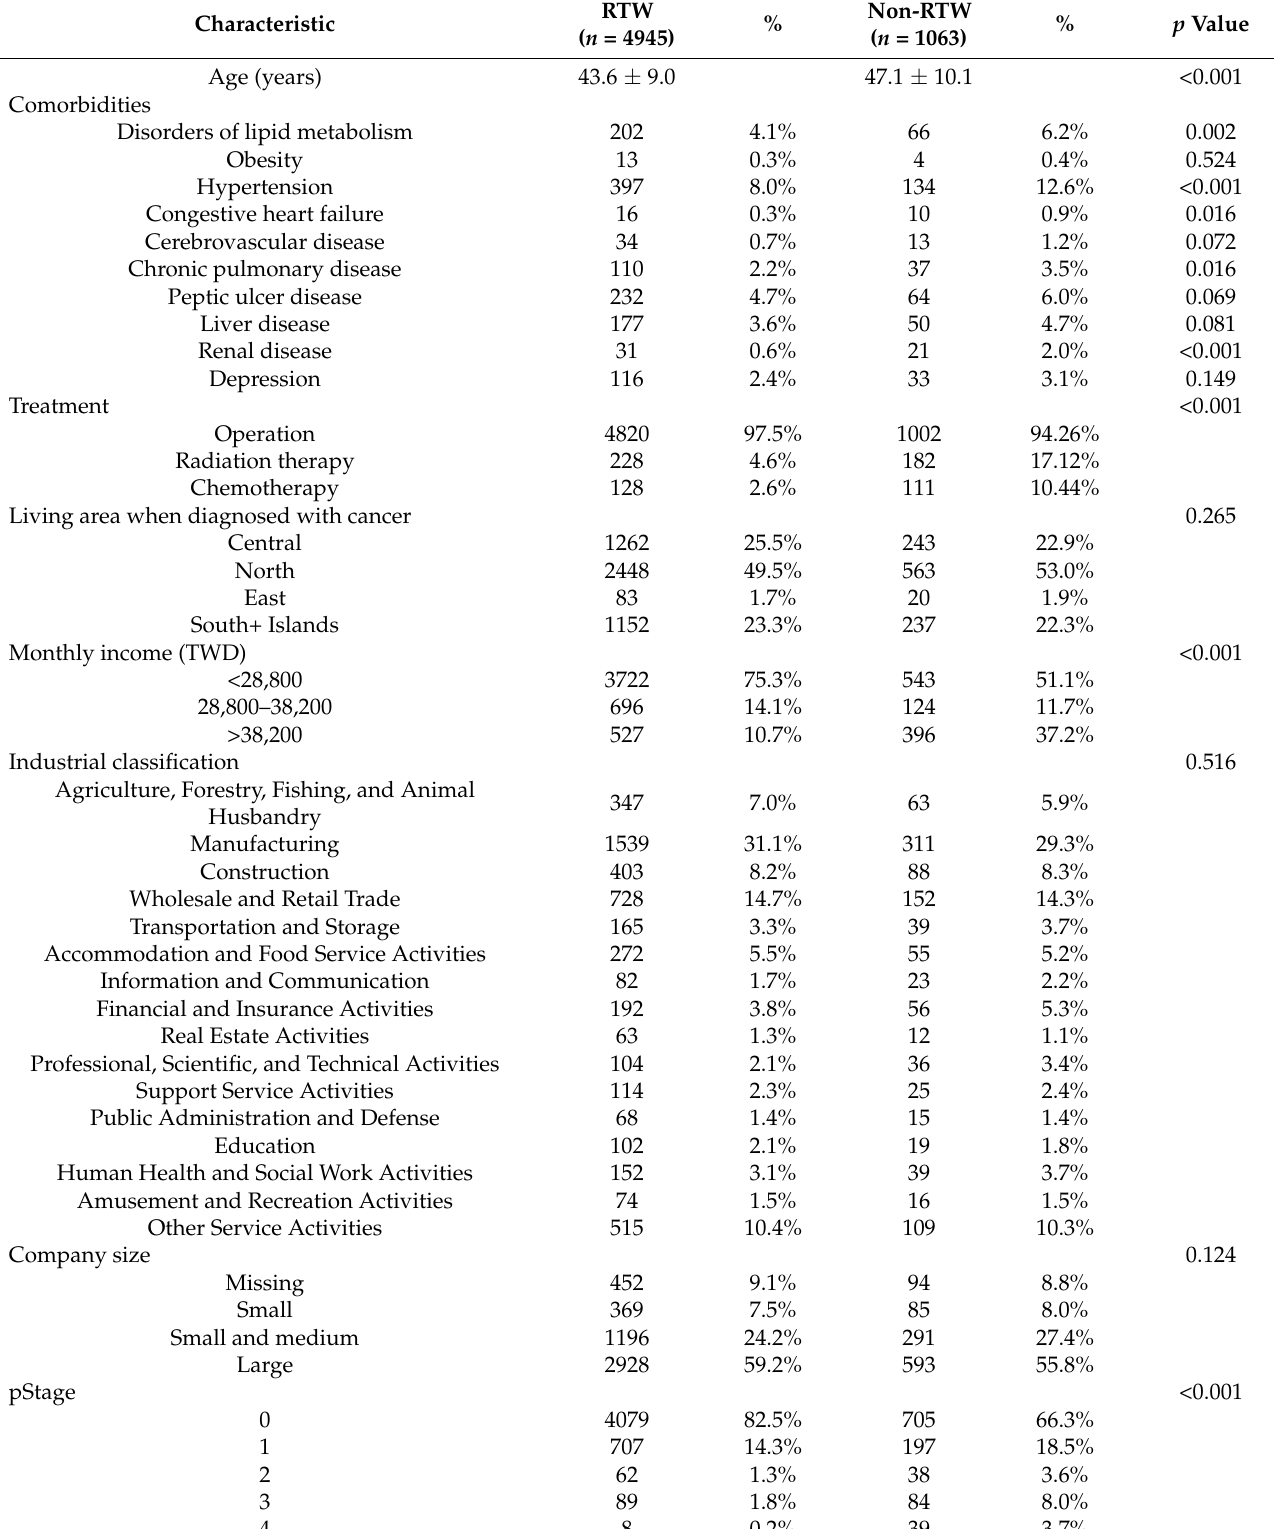
Table 1. Demographic data of RTW group and non-RTW group of cervical cancer